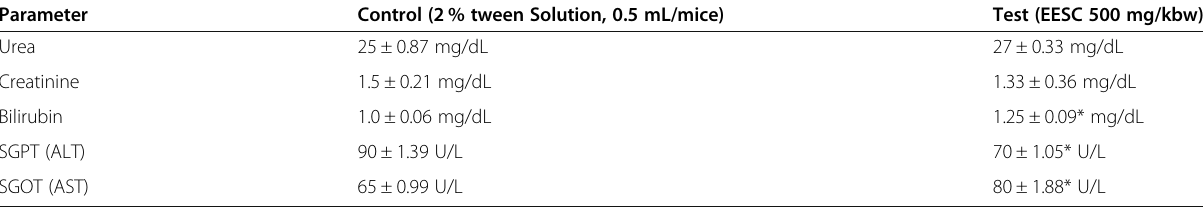
Table 4 Effect of ethanolic extract of S. caseolaris fruits on different biomarkers